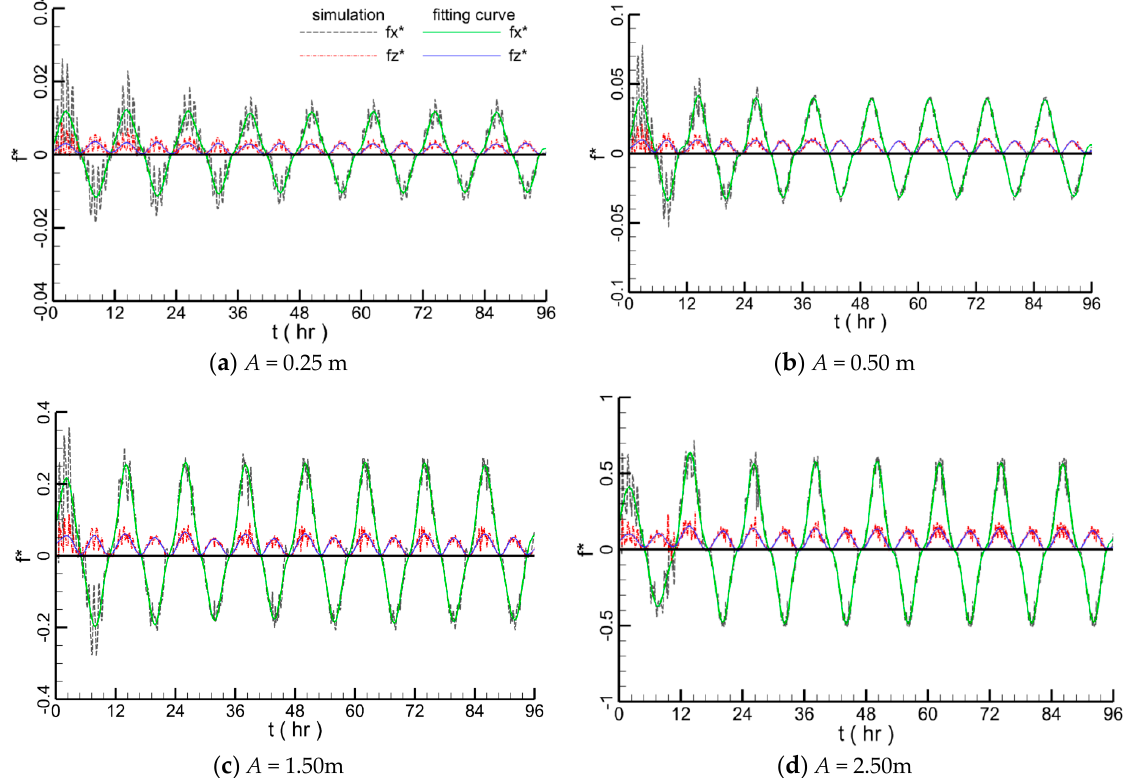
Figure 17. The hydrodynamic force on pipeline with different tidal amplitudes.